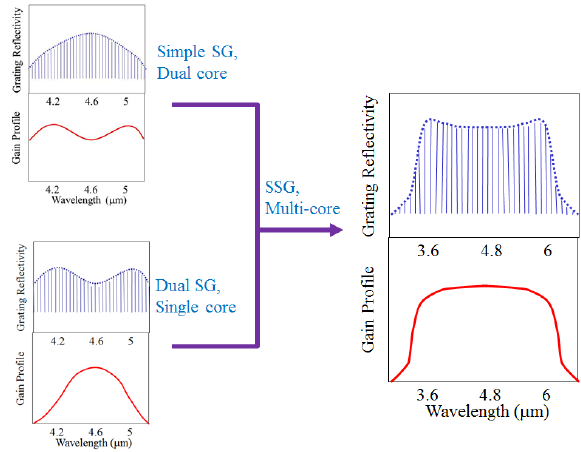
Figure 4 . Evolution of electrically tunable QCL design for extreme spectral coverage. Figure 4. Evolution of electrically tunable QCL design for extreme spectral